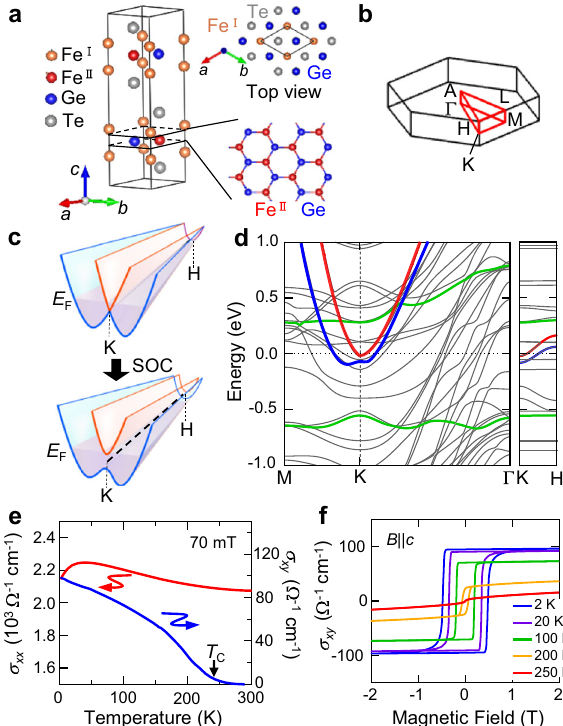
Fig. 1 Ferromagnetic van der Waals semimetal Fe 3 GeTe 2 with large anomalous Hall effect. a Crystal structure of Fe 3 GeTe 2 (left panel). The right upper and right lower panels illustrate the top view and honeycomb structure, respectively. b Brillouin zone of Fe 3 GeTe 2 with the high symmetry points. c Schematic illustration of the nodal line structure along KH line (upper panel). The spin orbit coupling (SOC) lifts the degeneracy along the nodal line structure, resulting in the gap opening (lower panel). d The band structure with considering the SOC along KM, K Γ and KH lines. The red and blue curves represent the bands composing the nodal line near the Fermi level. The green curves are examples of the fl at bands. e Temperature dependence of the longitudinal conductivity (red line) and Hall conductivity when cooled in the magnetic fi eld of 70 mT (blue line). f Magnetic- fi eld dependence of the Hall conductivity at various temperatures for the magnetic fi eld parallel to the c axis.